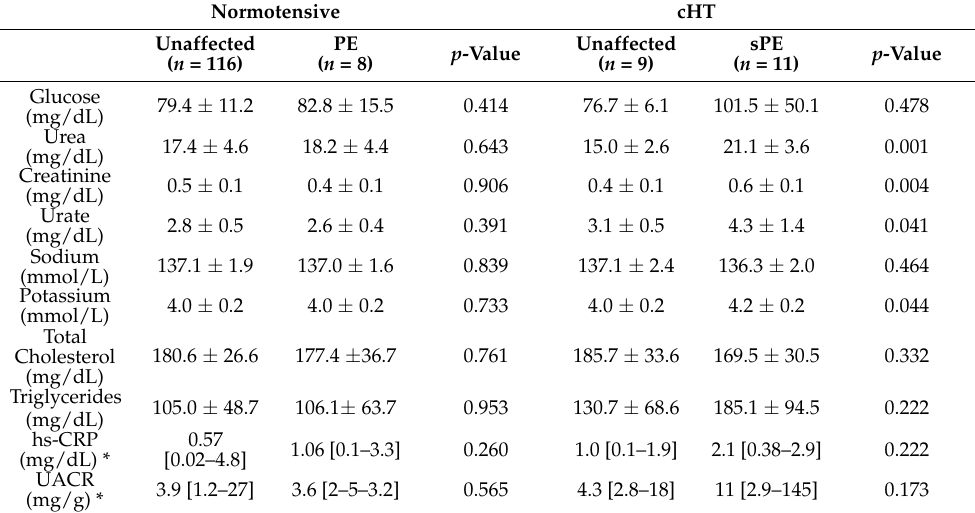
Table 5. Laboratory parameters in the first trimester in normotensive and chronic hypertensive pregnant women.